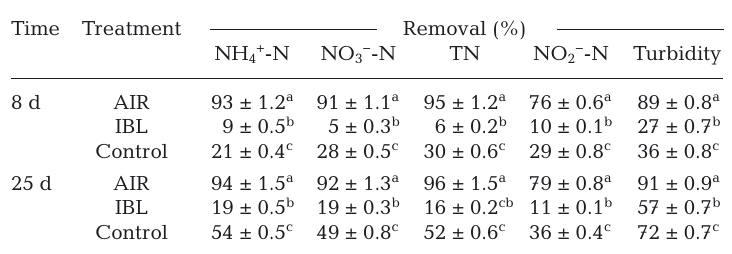
Table 2. Removal of nitrogenous pollutants and turbidity under aeration (AIR) and inactivated bacteria liquid (IBL) treatments with inoculation levels of Bacillus subtilis D9 at 5.5 × 10 8 cfu ml −1 (BD8) after 8 and 25 d. Data are means ± SD. Within columns, means with the same superscript letters are not significantly different (Tukey’s post hoc test, p > 0.05)